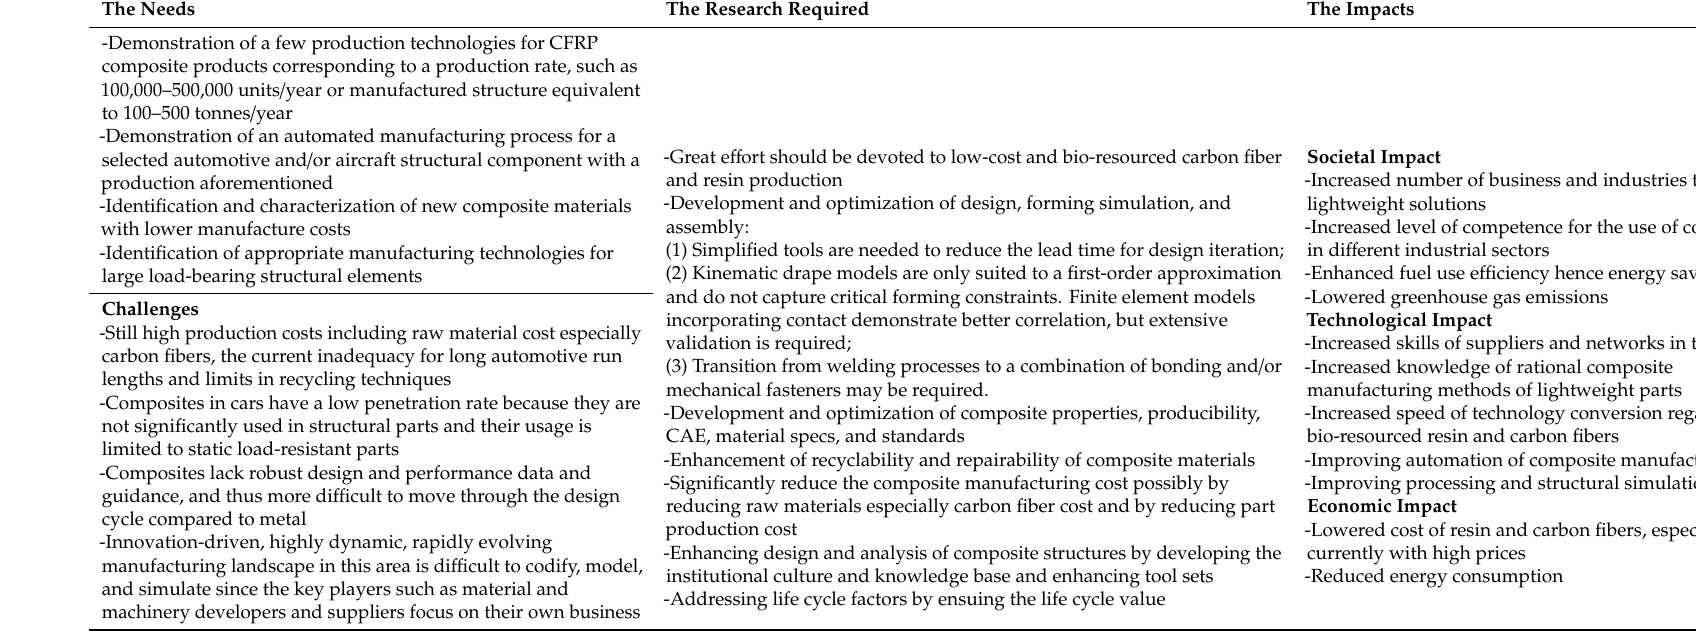
Table 1. The needs, research required, and the relevant impacts for the enhanced process throughput for high volume